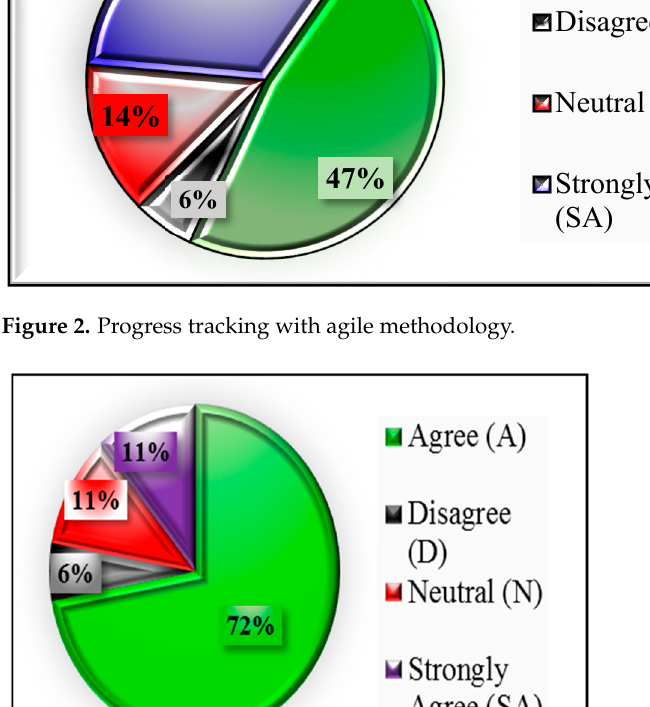
Figure 2. Progress tracking with agile methodology .